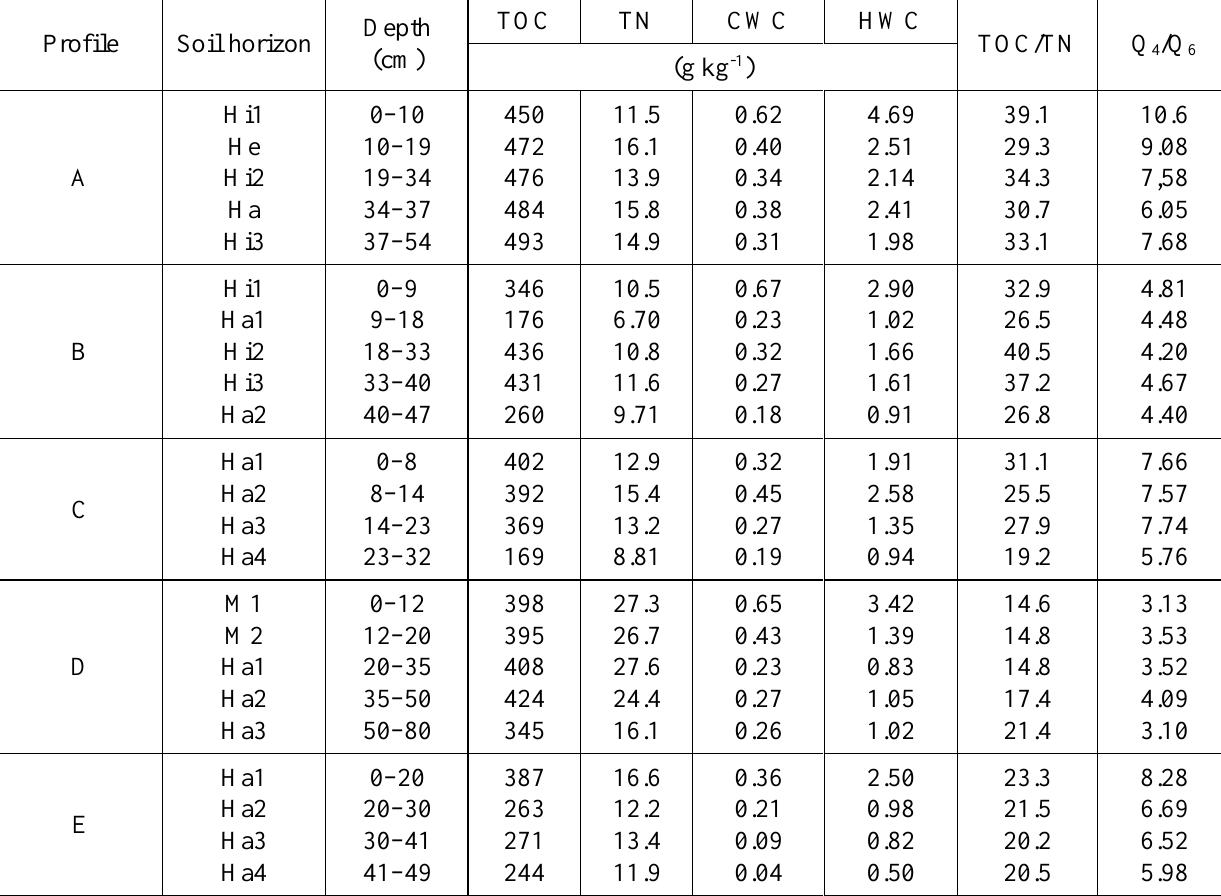
Table 5. Chemical properties of the soil horizons in Profiles A–E (mean values from three replicates, n = 69). Profile